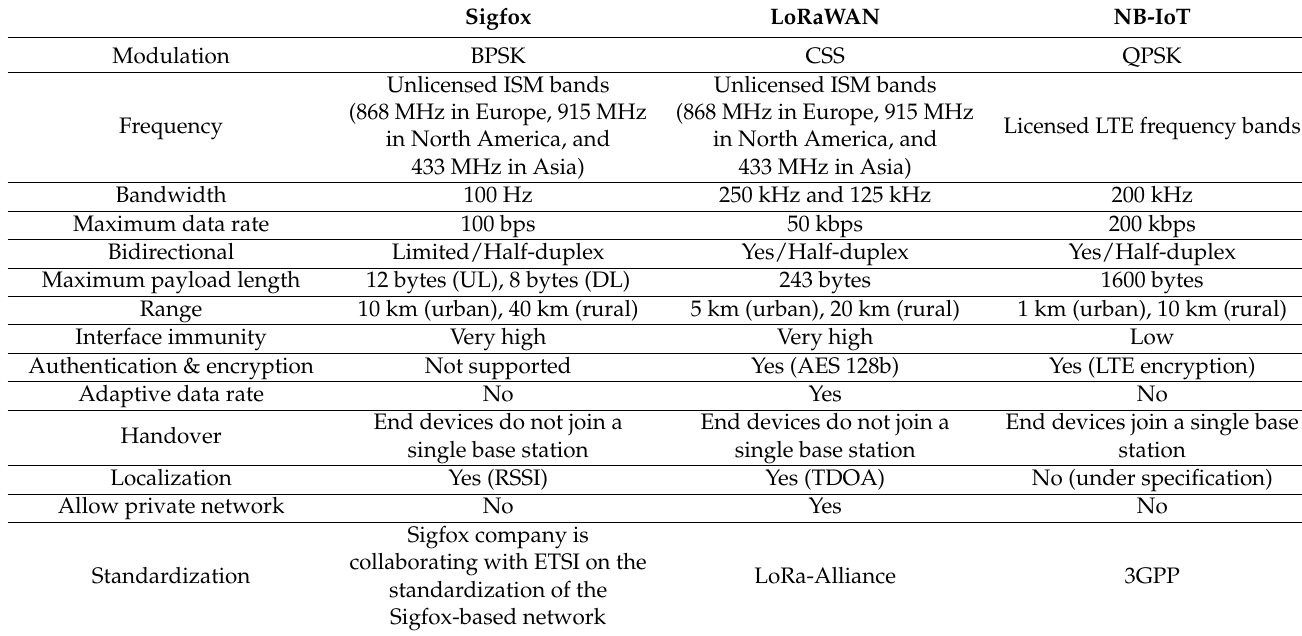
Table 1. Technical characteristics of LoRa, Sigfox, and NB-IoT [15].